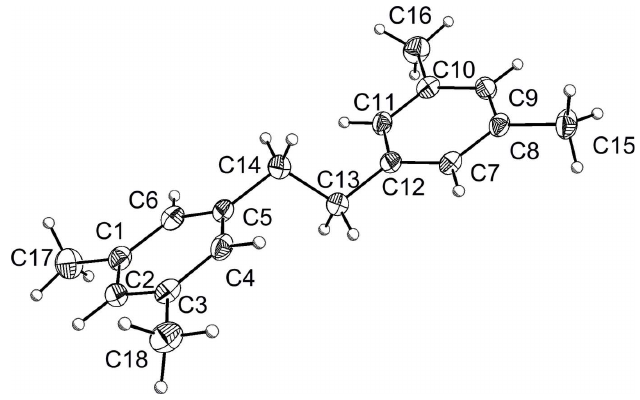
Figure 1 Molecular structure of the title compound, with displacement ellipsoids drawn at the 50% probability